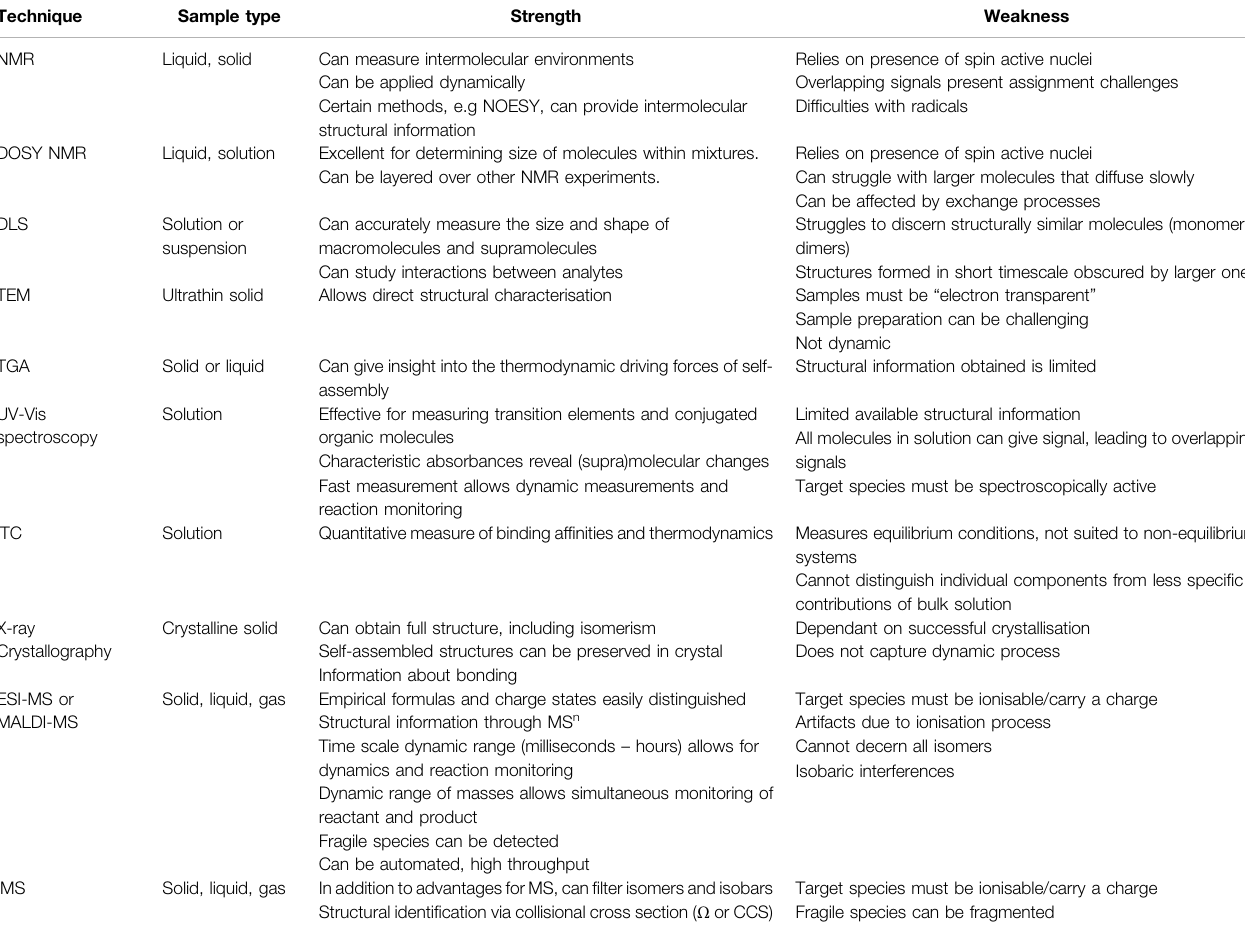
TABLE 2 | Techniques and their analytical strengths and weaknesses in the context of analysing CDSA structures and intermediates.